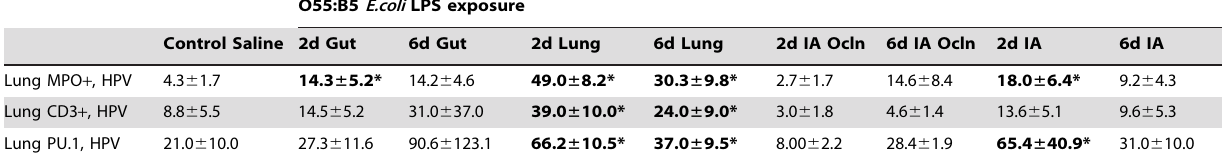
Table 4. Fetal lung immunocyte counts.